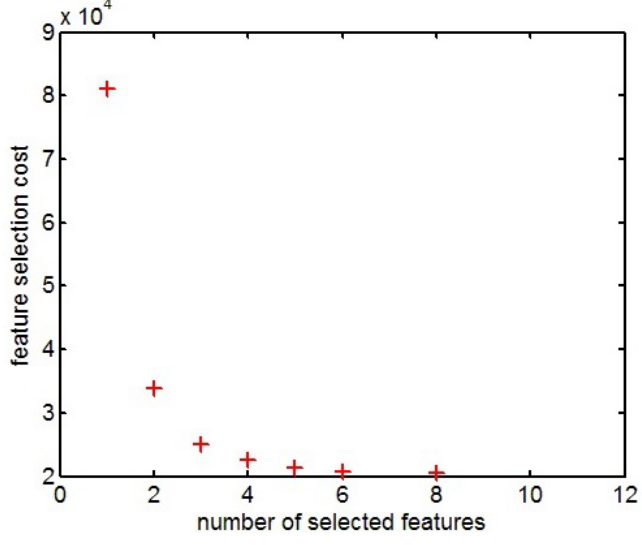
Figure 7. Pareto front of the